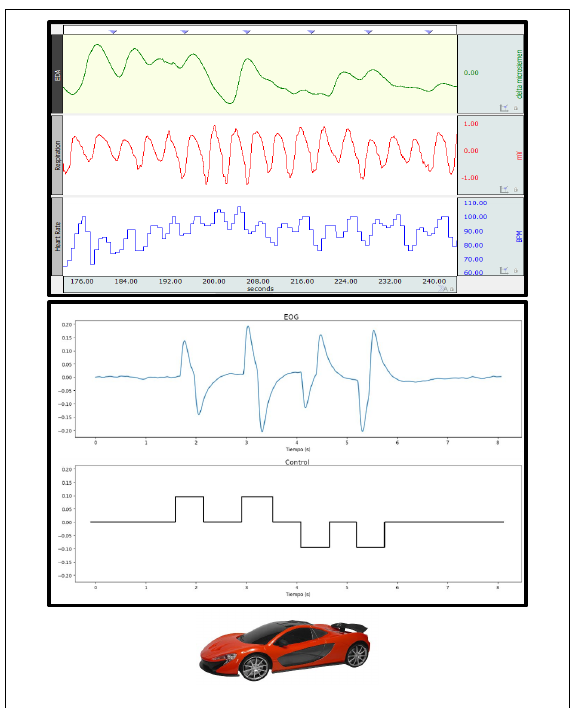
Figure 5. Experiments in practical modules —